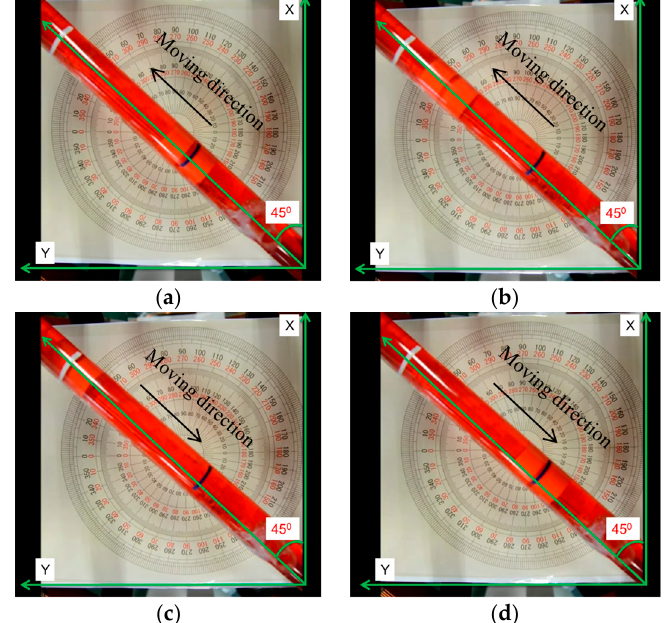
Figure 17. Locomotion direction is 45° direction with x -axis ( a ) Phase 1; ( b ) Phase 2; ( c ) Phase 3; ( d ) Phase.